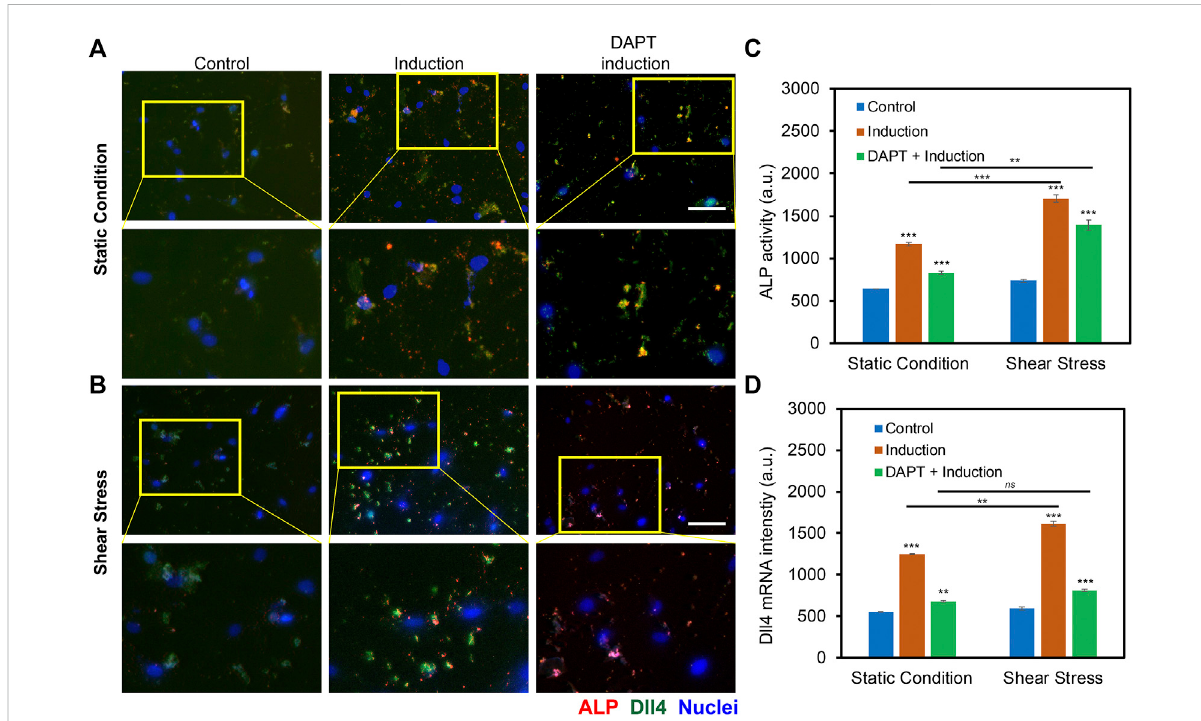
FIGURE 5 Notch signaling in regulating osteogenic differentiation of hMSCs with and without orbital shear stress. (A) Representative images of hMSCs in control, induction, and DAPT treatment groups without (A) and with (B) shear stress. Control: cells were cultured in the basal medium; induction: cells were cultured inosteogenic induction medium after cell seeding;DAPT: cells weretreated with DAPT (20 μ M) daily after osteogenic induction. Imagesweretakenafter5 daysofinduction.ThebottomimagesareenlargedareasofhMSCsinthelabeledyellowrectangle.Green:Dll4mRNA expression;red:ALPactivity;blue:nucleus.Scalebar:100 μ m. (C) ComparisonofALPactivityofhMSCswithandwithoutshearstressunderdifferent conditions. (D) Mean fl uorescent intensity of Dll4 mRNA expression of hMSCs after 5 days of osteogenic induction under different conditions as indicated.Error bars, s.e.m, with n = 100 – 150 cells. p -Values werecalculated using atwo-sample t -testwith respect to control. ns , not signi fi cant, *, p < 0.05; **, p < 0.01; ***, p <